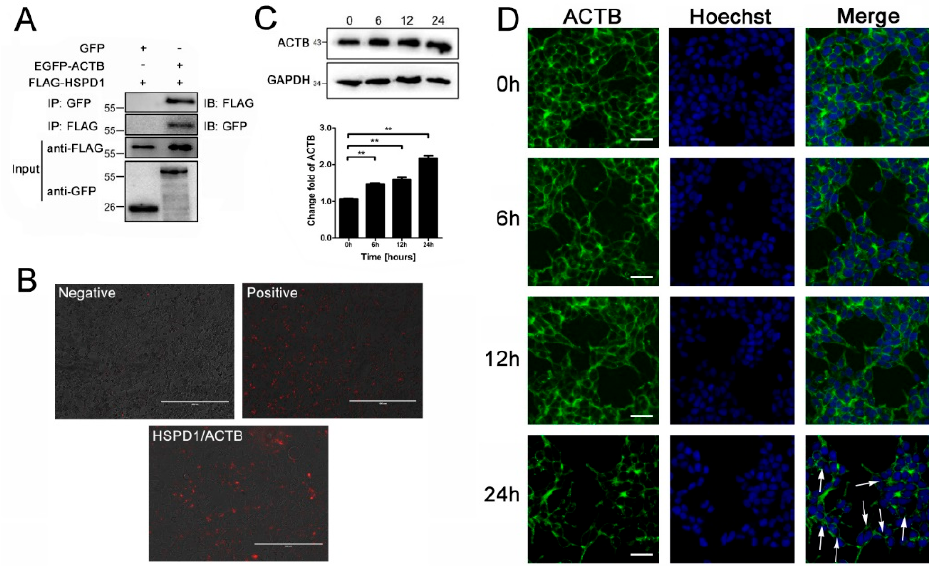
Figure 5. Eno promotes the expression of ACTB which interacts with HSPD1. ( A ) HSPD1-ACTB interaction shown by Co-IP. ( B ) HSPD1-ACTB interaction shown by BiFC. (Scale bar, 400 µm) ( C ) Western-blotting detection of ACTB expression in 293T cells after Eno treatment for 0, 6, 12, and 24 h. ( D ) Eno-induced morphological changes (indicated by white arrows) in cellular structures shown by immunofluorescent experiments. (Scale bar, 50 µm) (ACTB: β -actin; Co-IP: co-immunoprecipitation; BiFC: bimolecular fluorescence complementary) (**, p < 0.01)